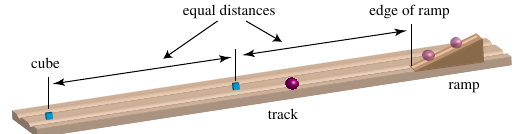
FIG. 4. Four graphs representing uniform